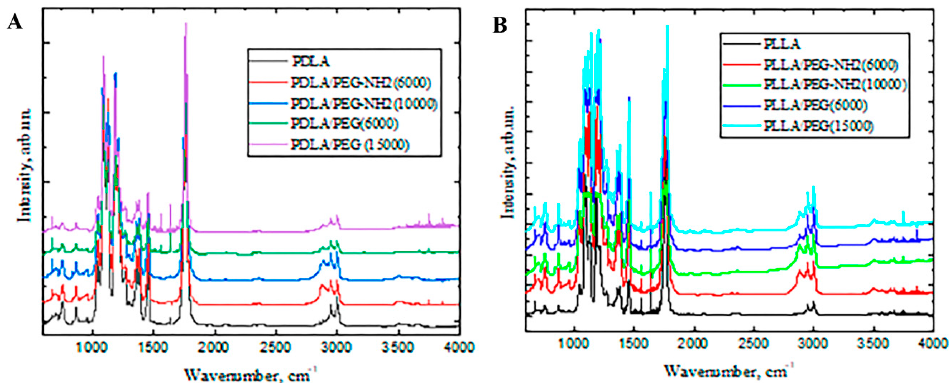
Figure2. Fouriertransforminfrared(FTIR)spectraofthepurePLAwithdi ff erentisomericforms—PDLA Figure 2. Fourier transform infrared (FTIR) spectra of the pure PLA with different isomeric ( A ) and PLLA ( B ); the blend PLA / PEG or PLA / PEG-NH2 with di ff erent molecular weights of forms—PDLA ( А ) and PLLA ( В ); the blend PLA/PEG or PLA/PEG-NH2 with different molecular weights of PEG (6000 or 15,000 g/mol) and PEG-NH2 (6000 or 10,000 g/mol).